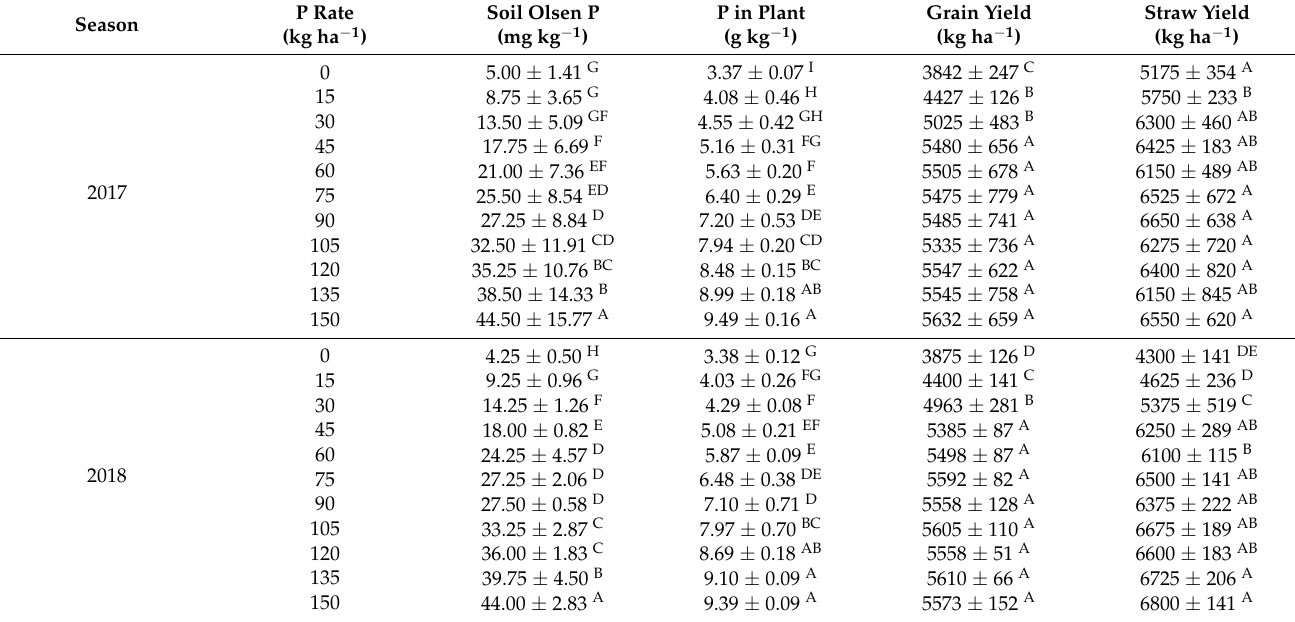
Table 3. Average values of soil Olsen P, P in plant, grain yield, and straw yield of wheat in the four growing seasons (2017–2020).